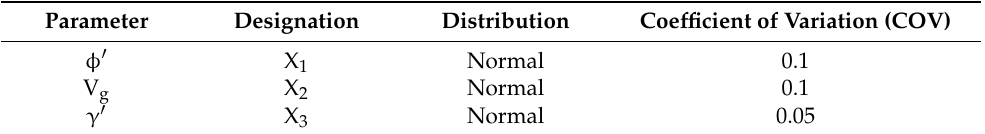
Table 3. Statistical characteristics of random variables.